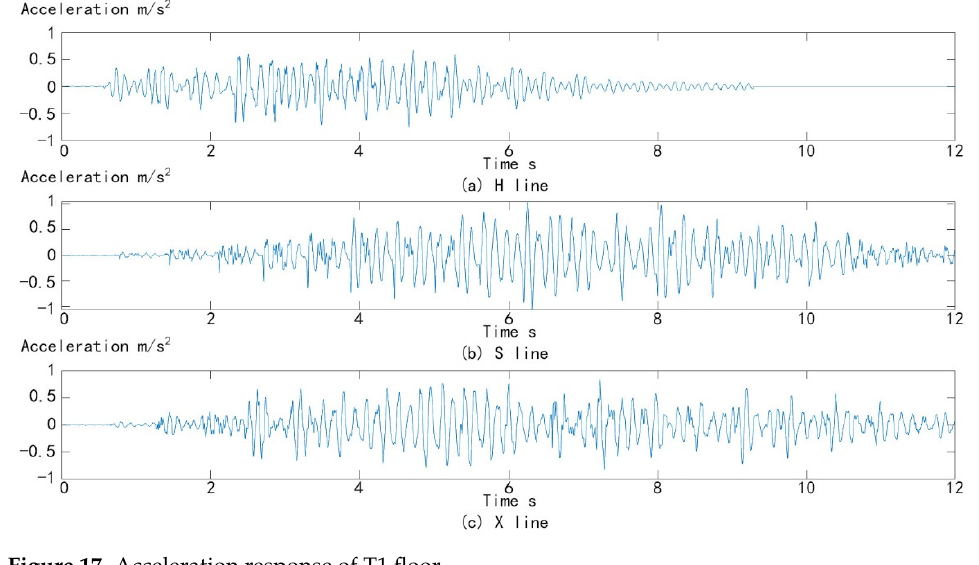
Figure 17. Acceleration response of T1 floor.